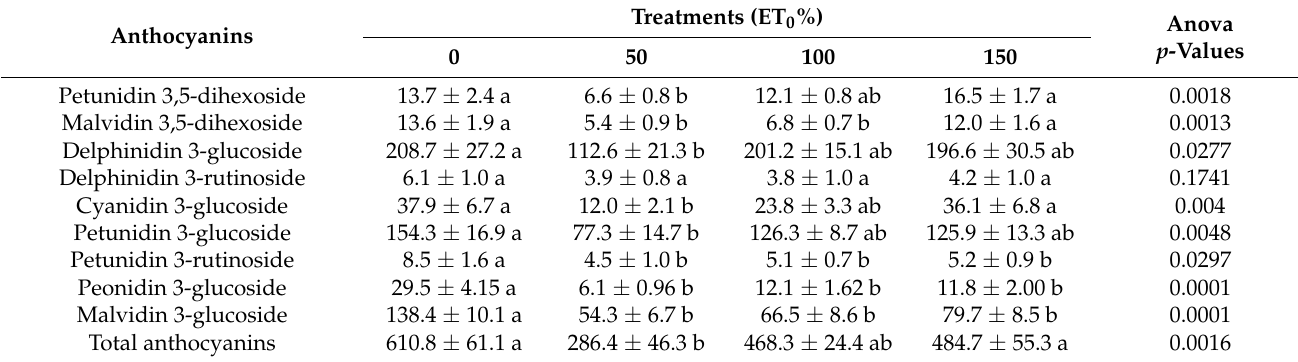
Table 4. Anthocyanins (mg 100 g − 1 ) of fresh calafate fruit by HPLC according to water replenishment